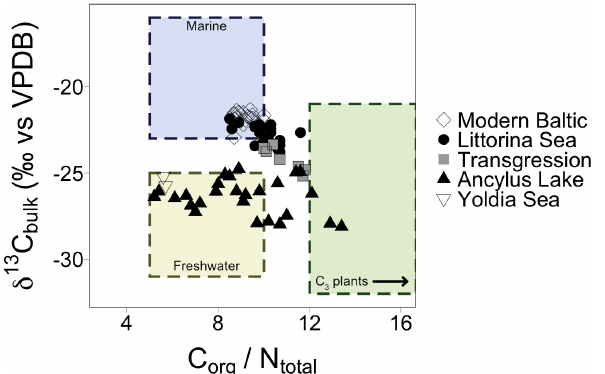
Figure 3. Elemental C / N ratios plotted against δ 13 C values of bulk sediment. Shapes correspond to different Baltic Sea phases and align with a mix of values corresponding to marine, freshwater, and C 3 plant signatures. The arrow in the C 3 plants box indicates that values for C 3 plants encompass a wider range of values which are excluded from this plot for